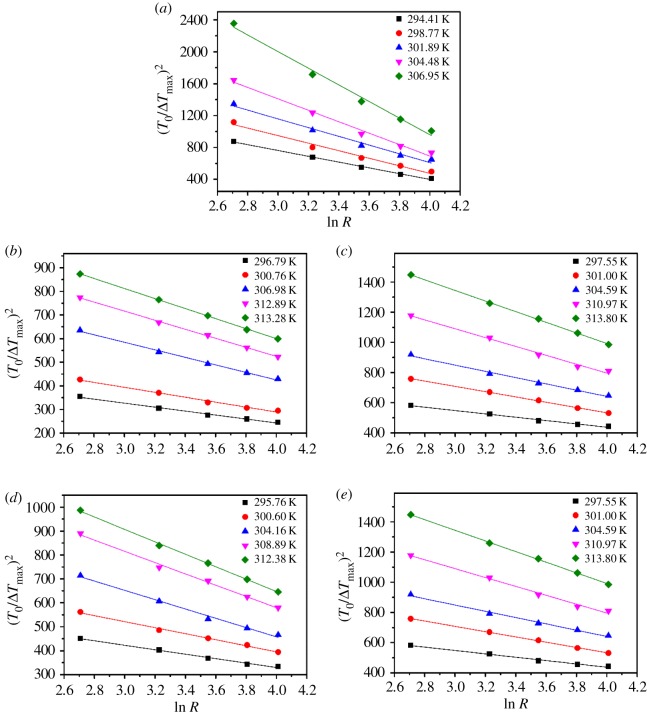
The plot of (T0/ΔTmax)2 versus ln R for borax in different mass percentages of sodium carbonate: (a) 0.00% Na2CO3; (b) 5.31% Na2CO3; (c) 7.09% Na2CO3 ; (d) 8.38% Na2CO3; (e) 9.22% Na2CO3.